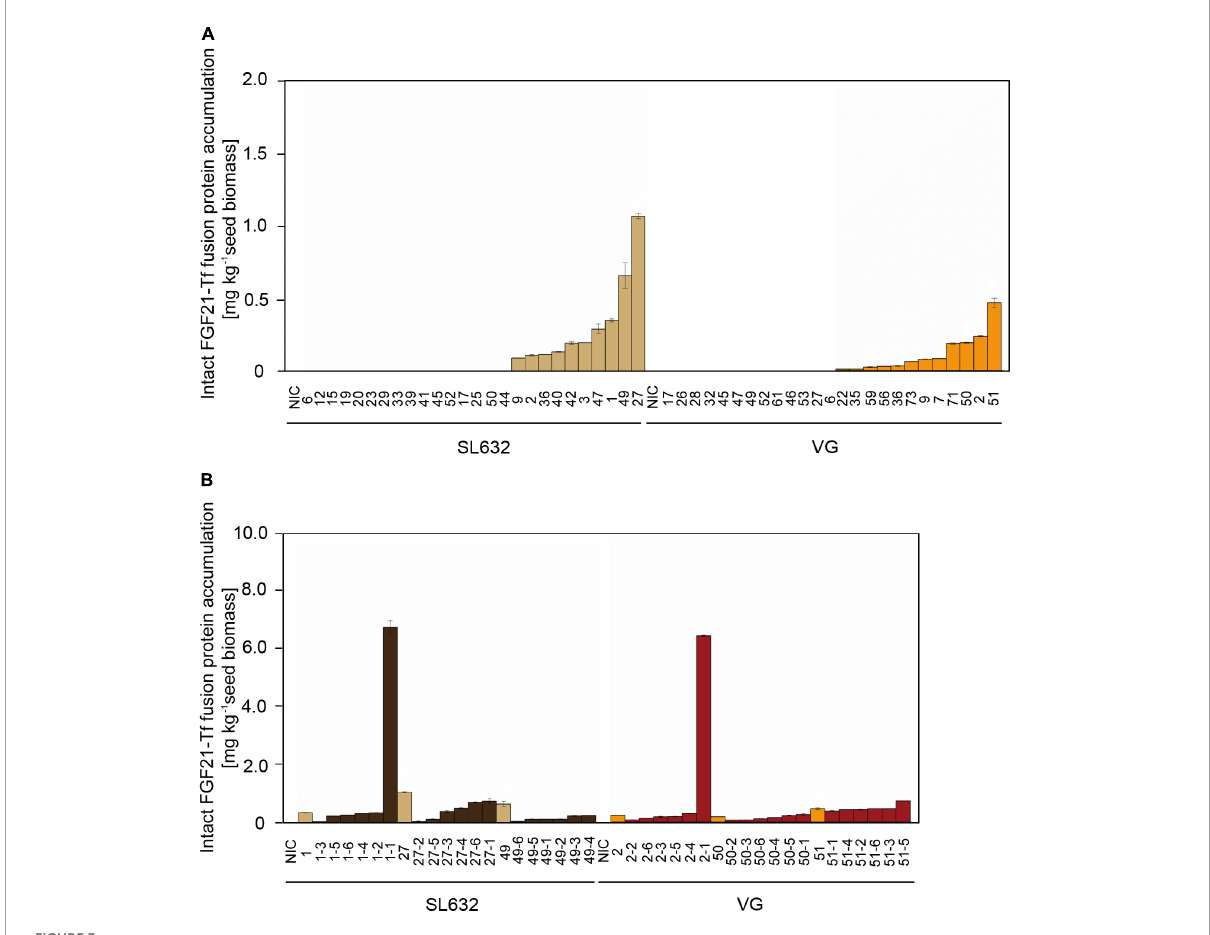
FIGURE3 Intact FGF21-F-Tf fusion protein yield in seeds of T0 and T1 transformants in N. tabacum SL632 and VG. (A) Intact FGF21-F-Tf fusion protein accumulation in seeds of T0 transformants. (B) Intact FGF21-F-Tf fusion protein accumulation in seeds of T1 descendants of selected T0 transformants 1, 27, and 49 of SL632 and 2, 50, and 51 of VG. Intact FGF21-F-Tf fusion protein accumulation was obtained through multiplying the ELISA-derived total product concentration by the fraction of intact FGF21-F-Tf determined via anti-FGF21 Western blot analysis. n = 2, biological replicates, i.e., different leave samples from the same plant. NIC, near-isogenic control